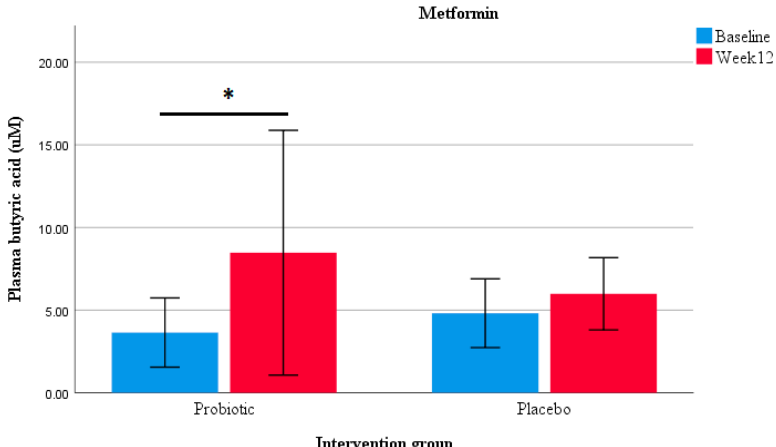
Figure 4. Plasma butyrate concentration. Box plots representing the effect on butyrate levels in participants taking metformin in the probiotic (n = 14) and placebo (n = 14) groups. * Wilcoxon matched-pairs signed rank test showing significant differences within the probiotic group (p < 0.05).